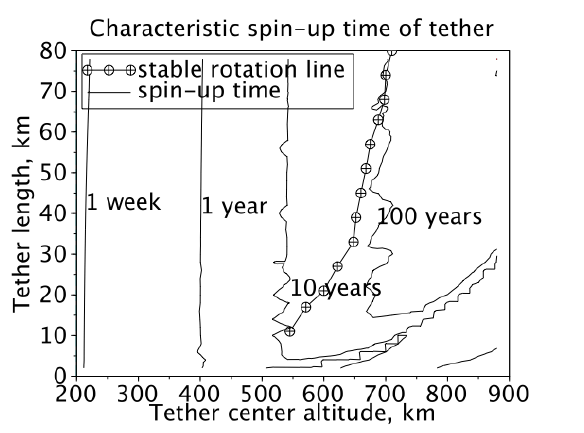
Figure 5. The characteristic spin-up time of tethers on equatorial circular